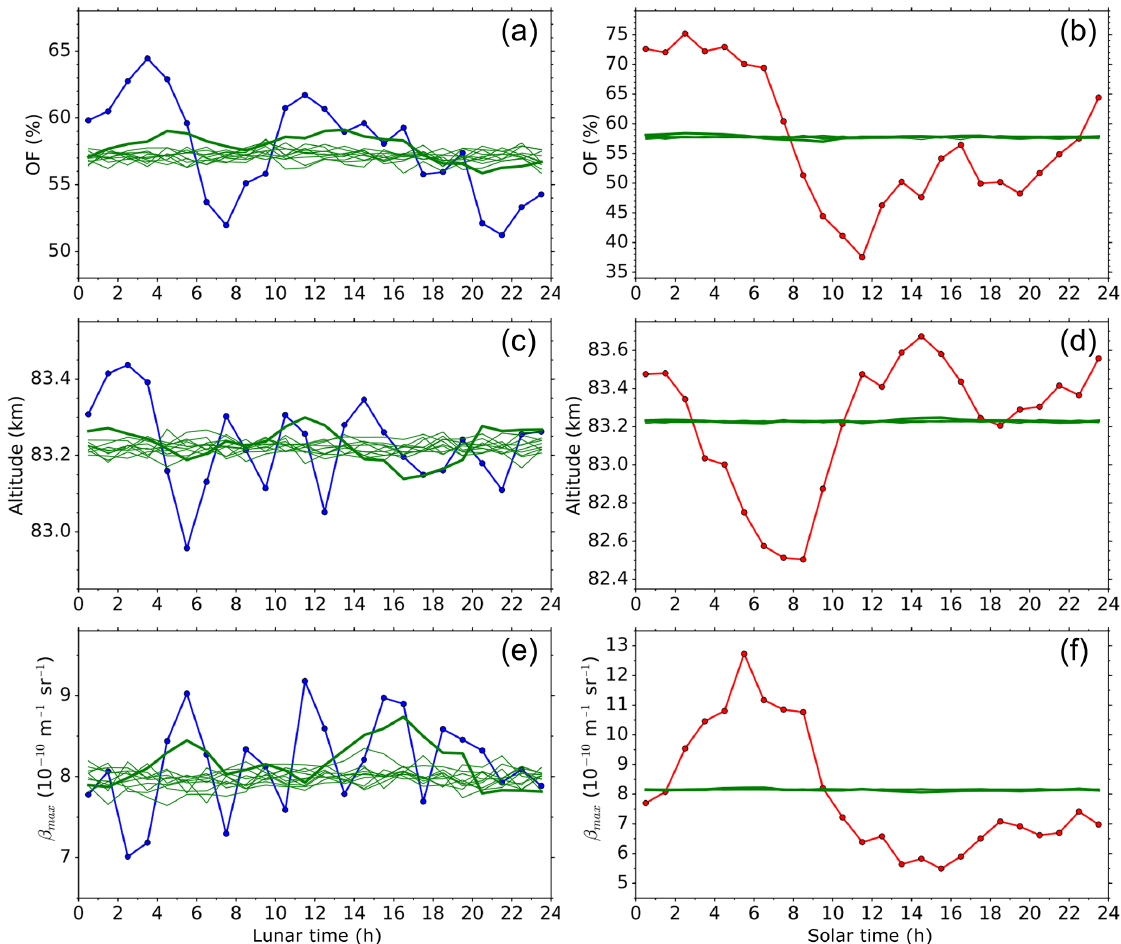
Figure 3. Simulated residual impact of solar on lunar (a, c, e) and lunar on solar (b, d, f) tidal variations, as introduced by the distribution of measurement times between 19 June and 29 July from 1997 to 2017. Method 1: actual times (thick green curves). Method 2: randomly generated times (thin green curves). Causative variations were reconstructed from harmonic fits with periods of 24, 12, 8 and 6h; see Table 1. For details see text. NLC parameters are occurrence frequency (a, b) , altitude (c, d) and brightness (e, f) . (a, c, e) Measured lunar dependence (blue) and simulated impact from solar variations (green). (b, d, f) Measured solar dependence (red), simulated impact from lunar variations